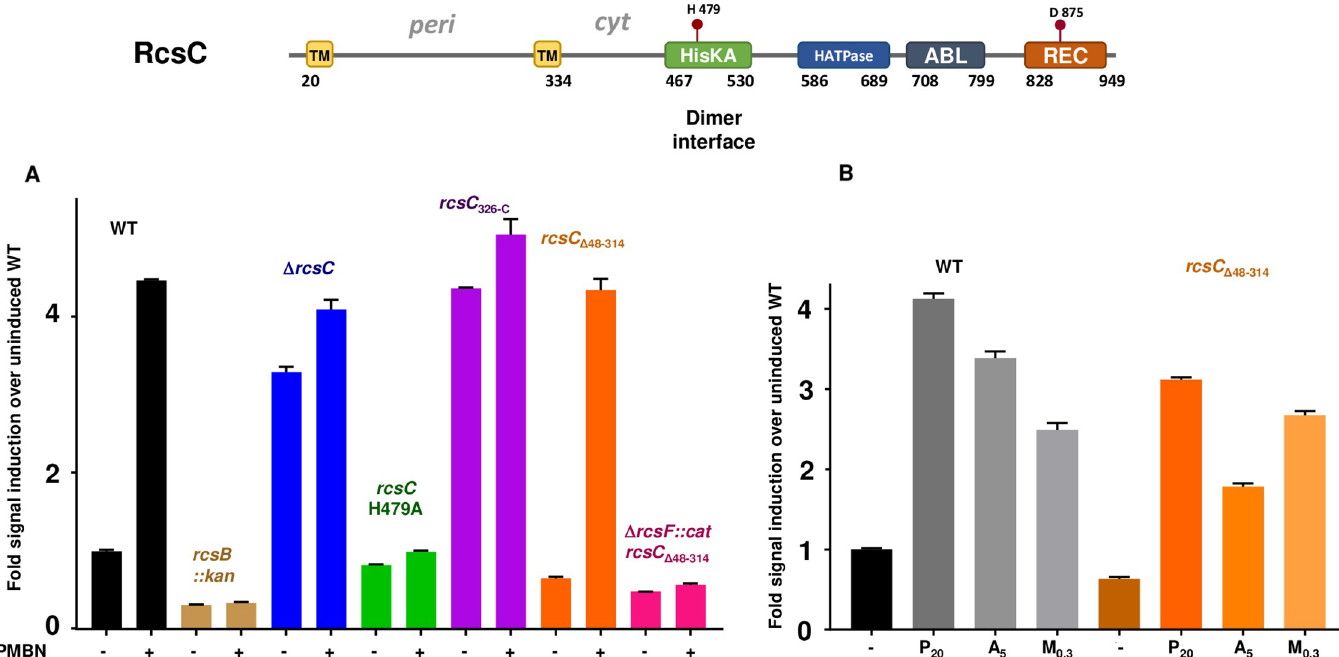
Fig 5. The RcsC periplasmic region is dispensable for polymyxin B nonapeptide (PMBN), A22, and mecillinam-induced signaling. The top panel shows a schematic of RcsC with domains, topology and active site residues noted. A. PMBN induction in various rcsC mutations. Strains included are (L to R) WT: EAW8, rcsB :: kan : EAW31, Δ rcsC : EAW91, rcsC H479A, mutant in the active site histidine: EAW92, rcsC 326-C : EAW56, rcsC Δ 48–314 : EAW70 and rcsF :: cat rcsC Δ 48–314 : EAW85. B. The effect of three Rcs stimulating drugs, PMBN, A22 and mecillinam (P 20 , A 5 , M 0.3 ) on WT and RcsC Δ 48–314 . The RcsC periplasmic deletion strain has a lower basal level of signal than WT here; this was also seen with other RcsC periplasmic deletions (S6B Fig).